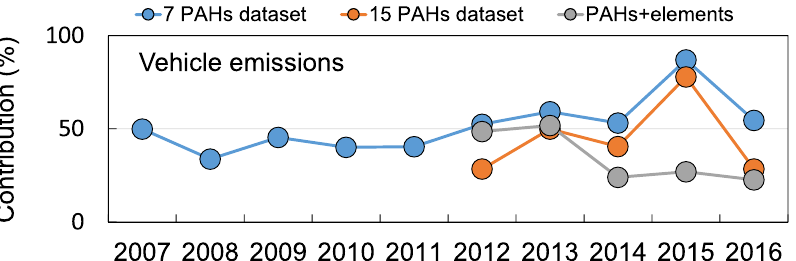
Figure 3. Contributions of vehicle emissions to 7 PAHs dataset, 15 PAHs dataset, and PAHs + elements,